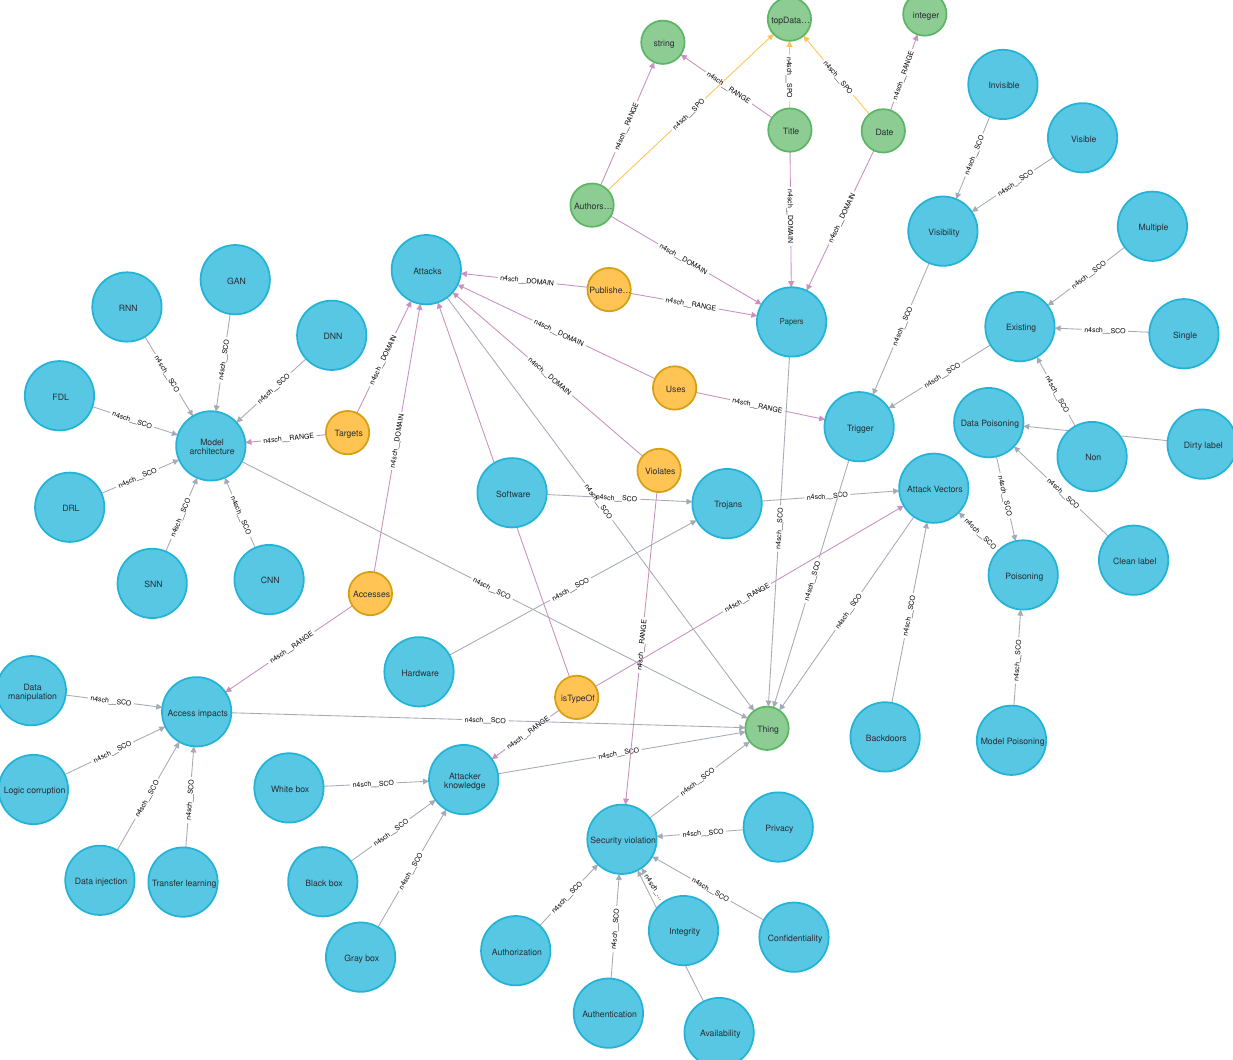
Figure 9. DNNPAO classes and subclasses with their relationships in Neo4j